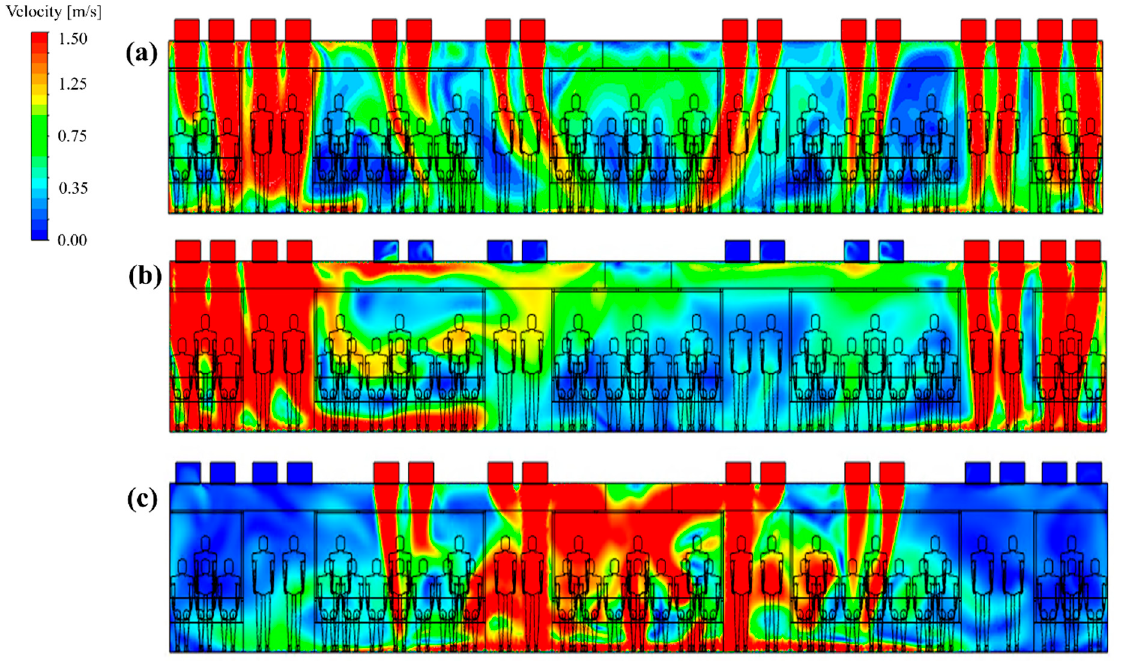
Figure 9. Airflow velocity distribution in the central section of the cabin according to the selected flow rate ratios (a total ventilation flow rate of 500 CMH and filter efficiency of 70% applied). ( a ) Case 1; ( b ) case 5; and ( c ) case 23.